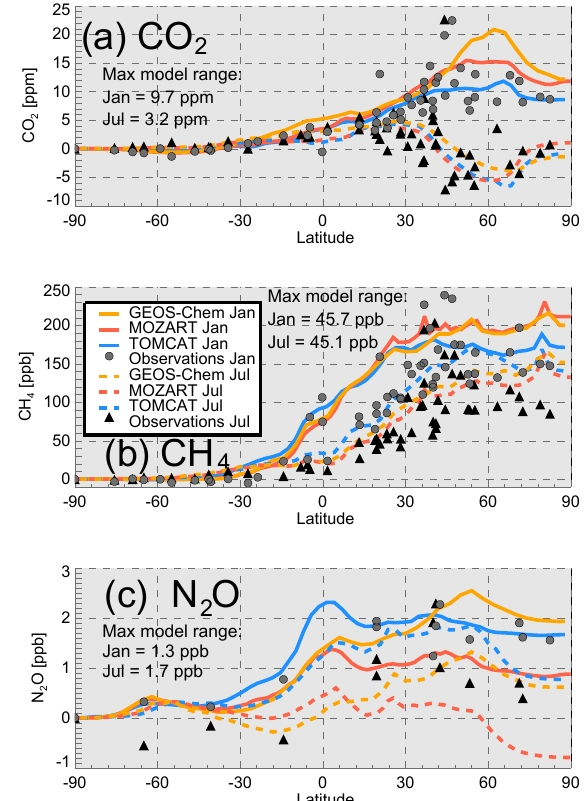
Figure 9. Simulated and observed surface zonal-mean latitudinal gradient of (a) CO 2 (ppm), (b) CH 4 (ppb), and (c) N 2 O (ppb) in January (solid lines and circles) and July (dashed lines and trian- gles) 2011. Observations are made as part of the NOAA/ESRL mea- surement campaign. For each model, its South Pole value is sub- tracted for all latitudes. Observations are treated